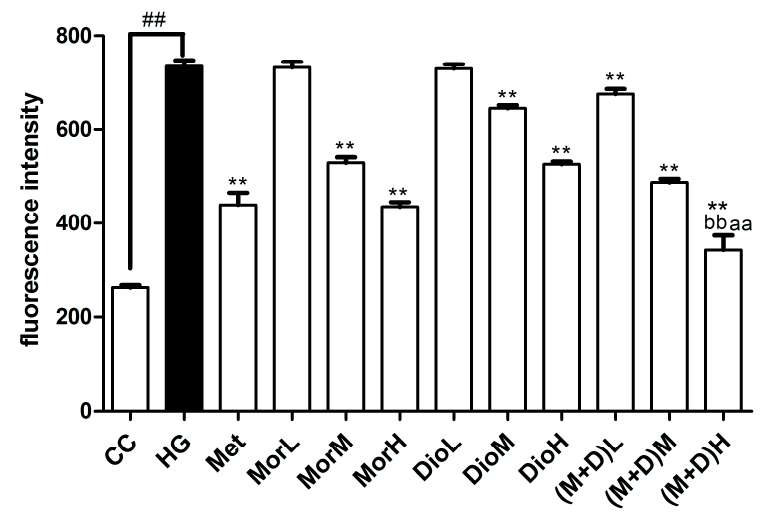
Figure 3. (M + D)H protects cardiomyocytes from mitochondrial production ROS induced with HG as determined with DCFH staining. Data are expressed as mean ± SD. ## p < 0.01 vs. CC; ** p < 0.01, vs. HG; aa p < 0.01, vs. MorH; bb p < 0.01, vs. DioH.